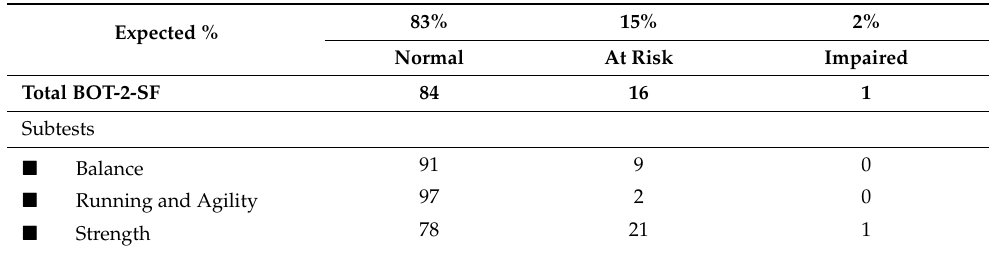
Table 4. Percentage per motor skill classification based on BOT-2 total scores and subtest